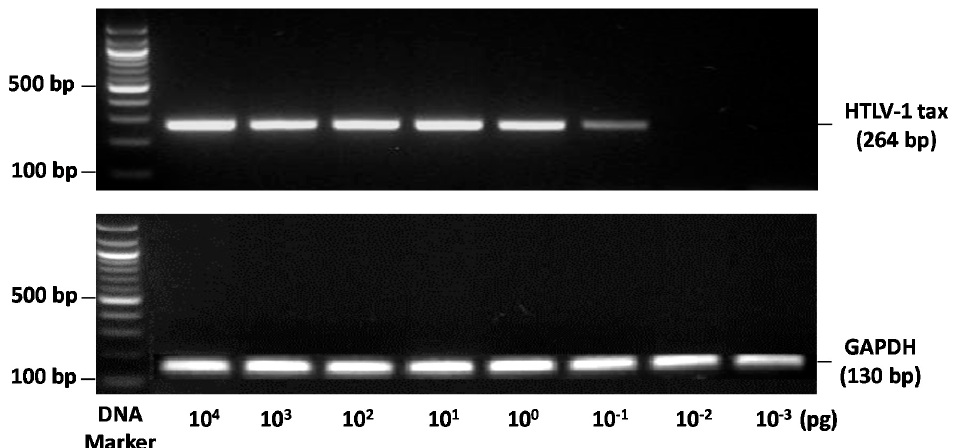
Figure 1. Sensitivity of human T-cell lymphotropic virus type 1 (HTLV-1) Tax PCR detection. End-point PCR method able to specifically detect a single HTLV-1 Tax DNA amplimer from 0.1